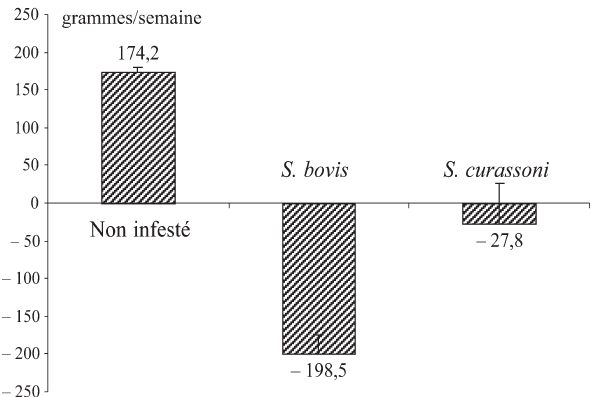
Fig. 1. – Moyenne (+ écart-type) par groupe des gains pondéraux hebdomadaires moyens sur la durée du suivi chez des caprins expé- rimentalement infestés par deux espèces de schistosomes et chez des témoins non infestés. Trois animaux par